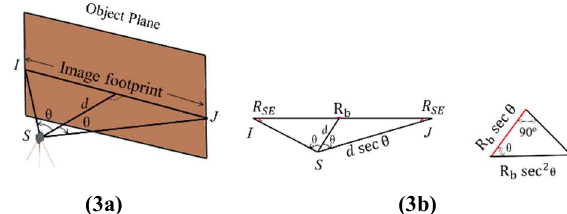
Figure 3. (3a) Normal geometry (image and object planes are parallel) (after Wolf, 2018), (3b) GSD for normal geometry